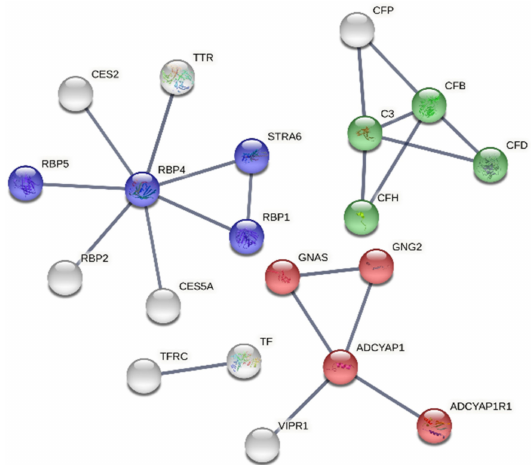
Figure 5. The protein–protein interaction network of proteins corresponding to the high-PACAP (pi- tuitary adenylate cyclase-activating polypeptide)-concentration group. Colour indicates proteins take part in retinol binding (blue), adenylate cyclase-modulating G protein-coupled receptor signalling pathway (red), complement activation and alternative pathway (green). White colour indicates the second shell of interactors. Our input: ADCYAP1: pituitary adenylate cyclase-activating polypeptide; CFB: complement factor B; RBP4: retinol-binding protein 4; TF: